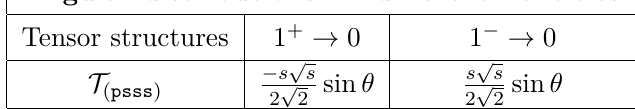
Table 6 . Angular distributions for the psss tensor